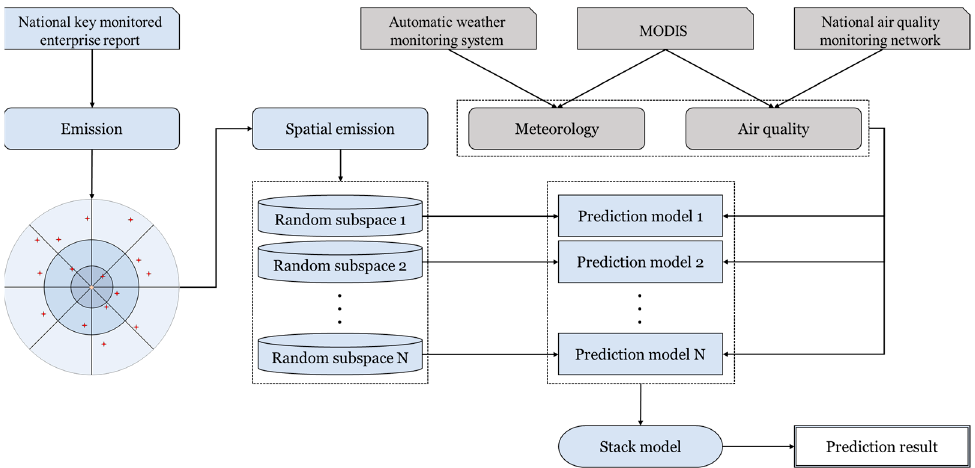
Figure 1. The air quality forecasting framework. Legend: MODIS, moderate-resolution imaging spectroradiometer.